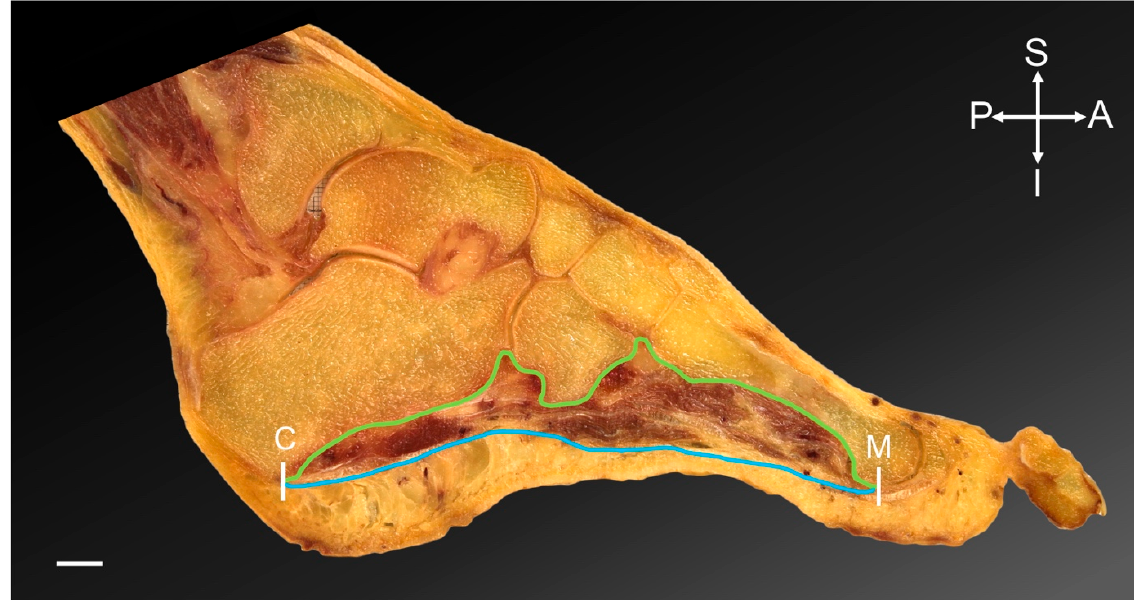
Figure 1. Foot section, sagittal plane. The region of interest of the plantar muscular space of the foot is highlighted. White lines indicate the anterior and posterior margins; the head of the metatarsal 1–5 (M) and the calcaneus (C). The blue line represents the inferior margin of the space with the plantar aponeurosis inferiorly. The green line indicates the superior boundary, which is the bony margins of the longitudinal arch of the foot. Scale bar = 10 mm. A = anterior; I = inferior; P = posterior; S = superior.